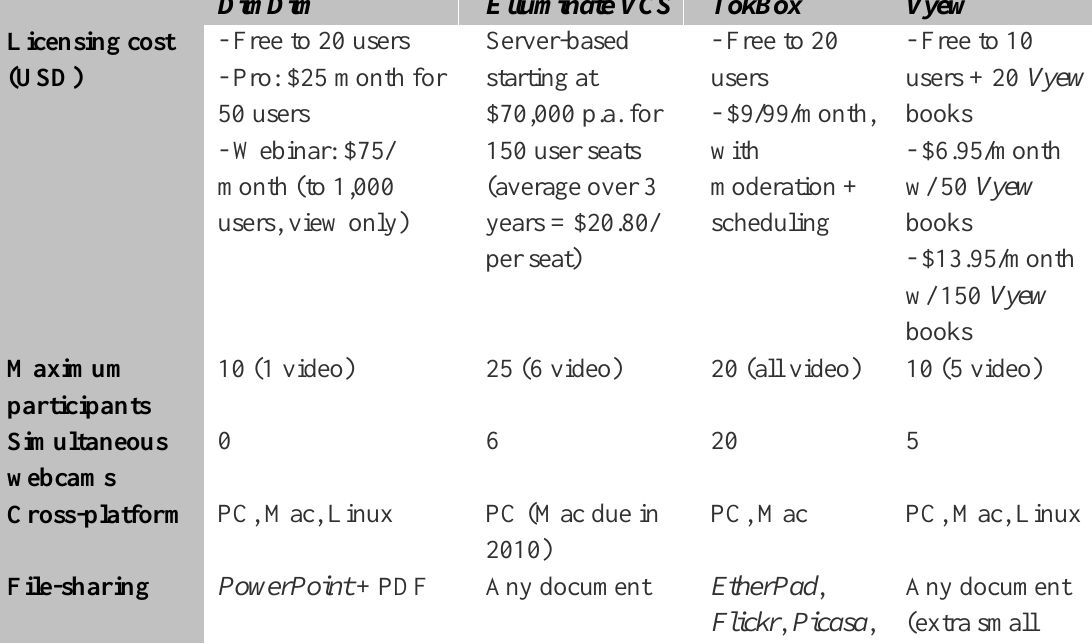
The Four Products’